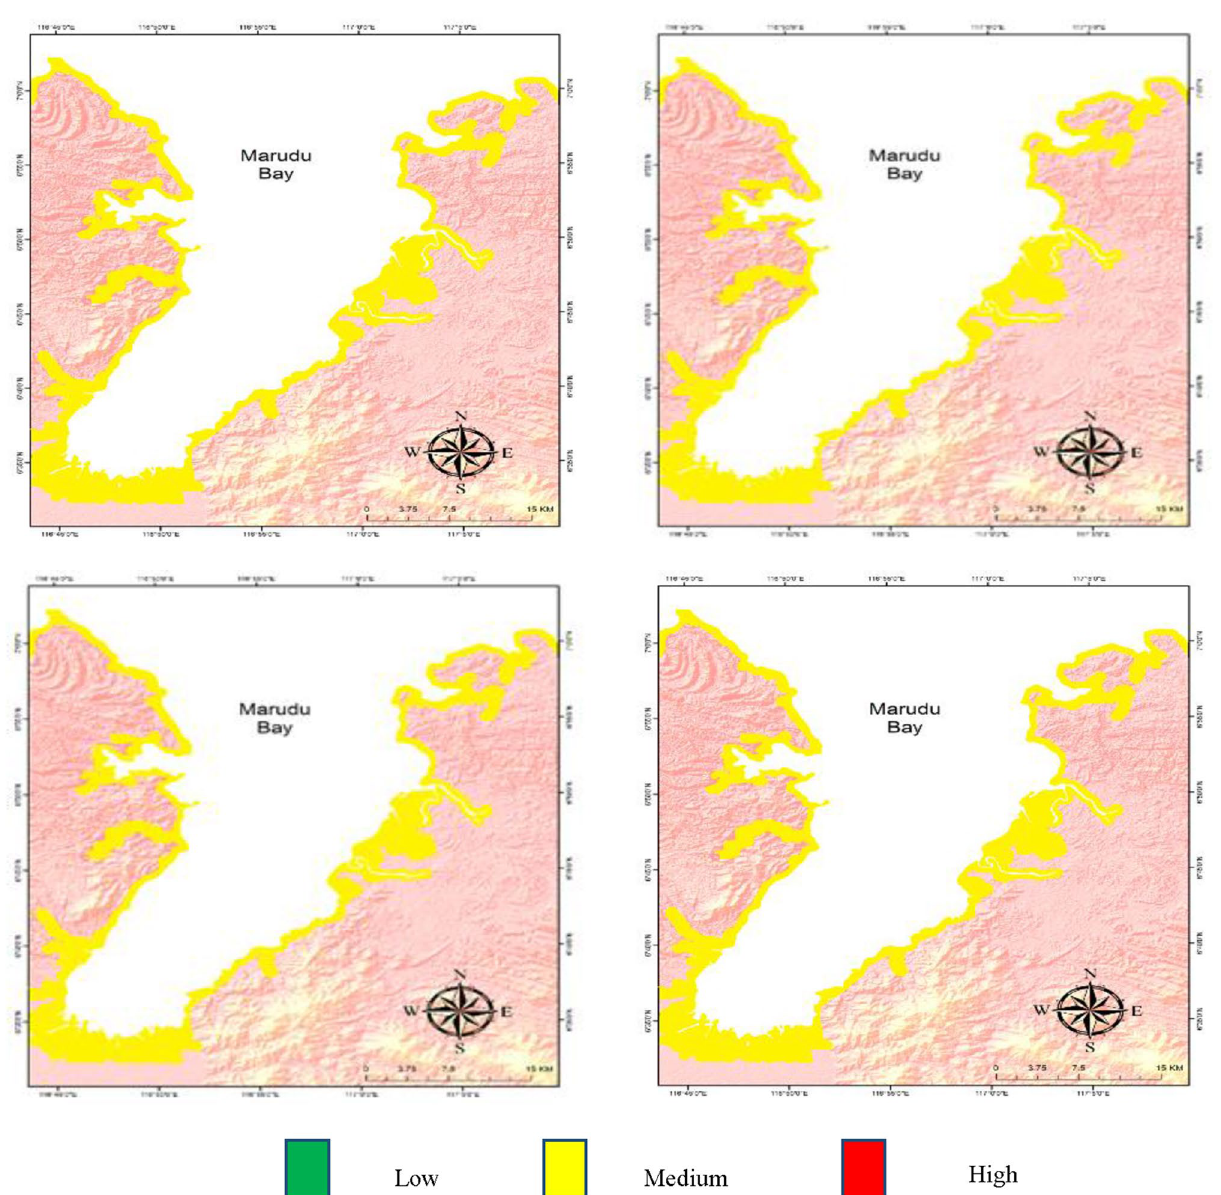
Fig. 8 CCVI for coastal Marudu bay at 2050 (left panel) and 2100 (right panel) during winter monsoon (top panel) and summer monsoon (bottom panel) under RCP 4.5 climate change